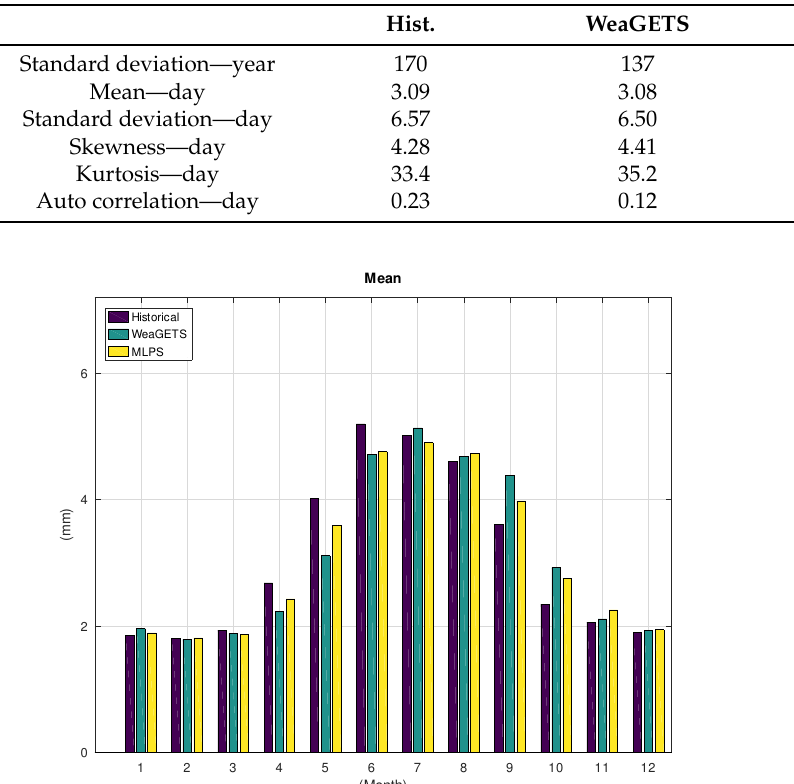
Figure 2. Monthly mean of the synthetic (WeaGETS and MLPS) and historical time series of the Hohenpeissenberg weather station.